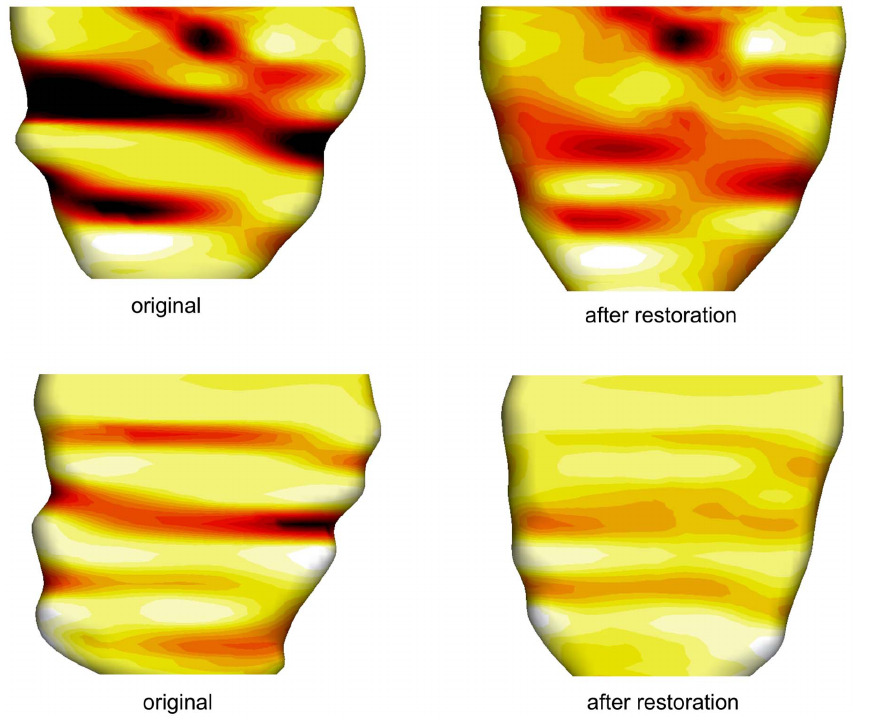
Figure 7. Patient-specific 3D LV mesh model restoration results. Two samples of patient-specific 3D LV mesh model before and after dual and free form geometric deformation.